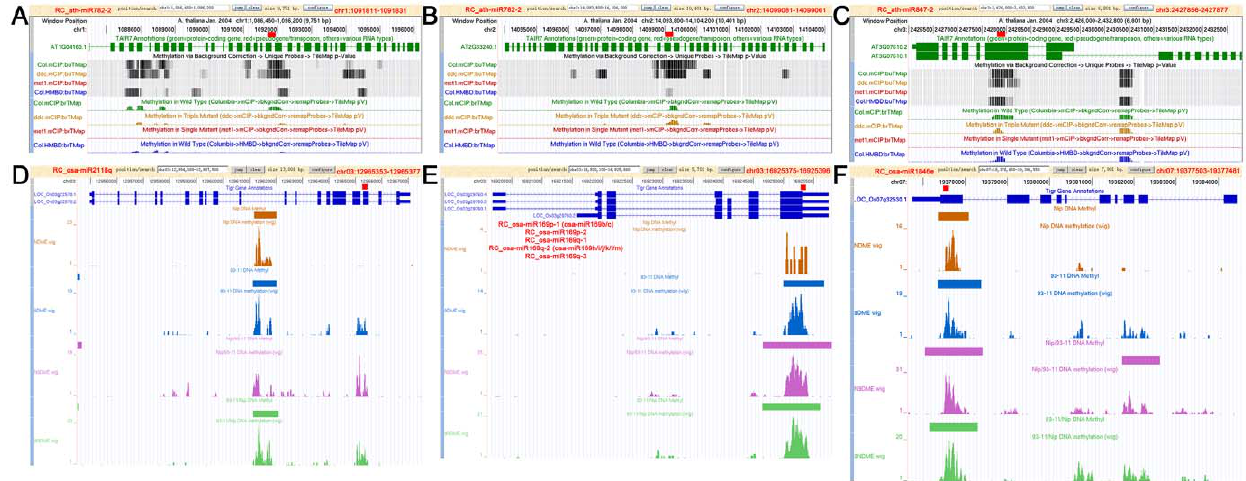
Figure 4. Site-specific DNA methylation mediated by the highly accumulated reverse complementary microRNAs (RC-miRNAs) in Arabidopsis and rice. (A) and (B) RC-ath-miR782-2-mediated DNA methylation on the region encoding AT1G04160 and AT2G33240 . (C) RC-ath- miR847-2-mediated DNA methylation on the region encoding AT3G07610 . (D) RC-oas-miR2118q-mediated DNA methylation on the region encoding LOC_Os03g22570 . (E) RC-oas-miR169p/q-mediated DNA methylation on the region encoding LOC_Os03g29760 . (F) RC-oas-miR1846e-mediated DNA methylation on the region encoding LOC_Os07g32530 . The genomic positions of the target binding sites of the RC-miRNAs are shown on the top right corners of the screenshots of the public available epigenome browsers of Arabidopsis and rice [29,30].